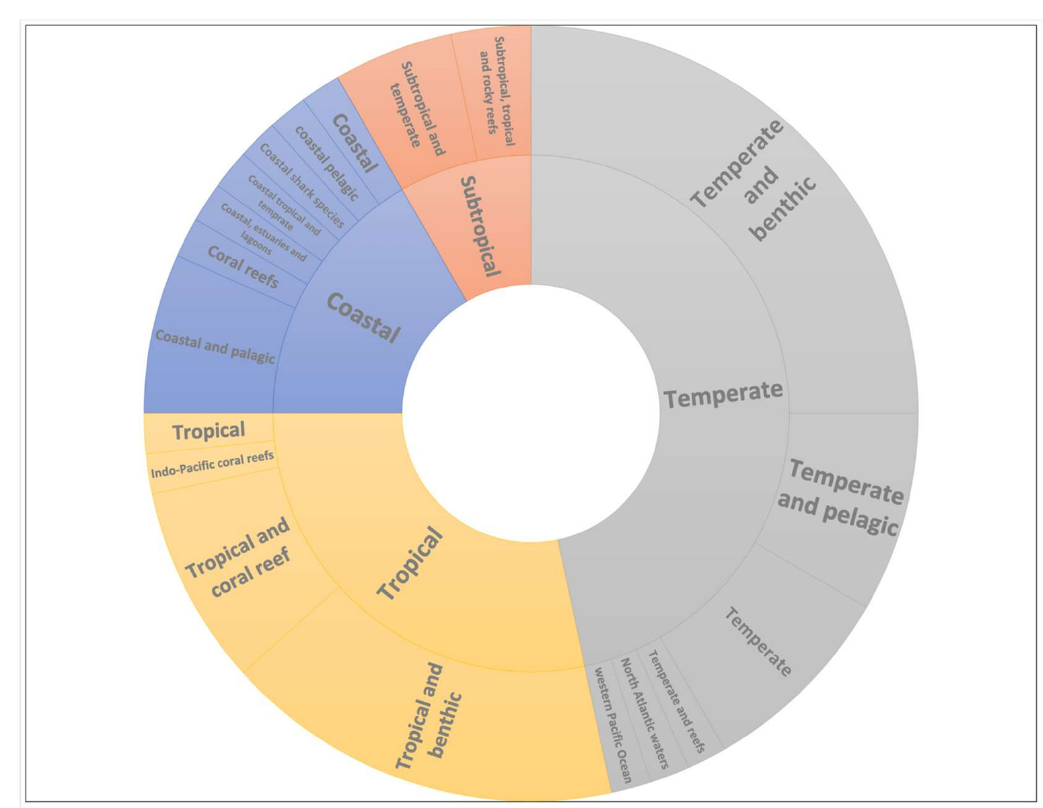
Figure 8. Studies categorized by the habitat and climatic region of the fish being studied. Most studies were conducted on the temperate and tropical zones, and none on the polar and sub-polar